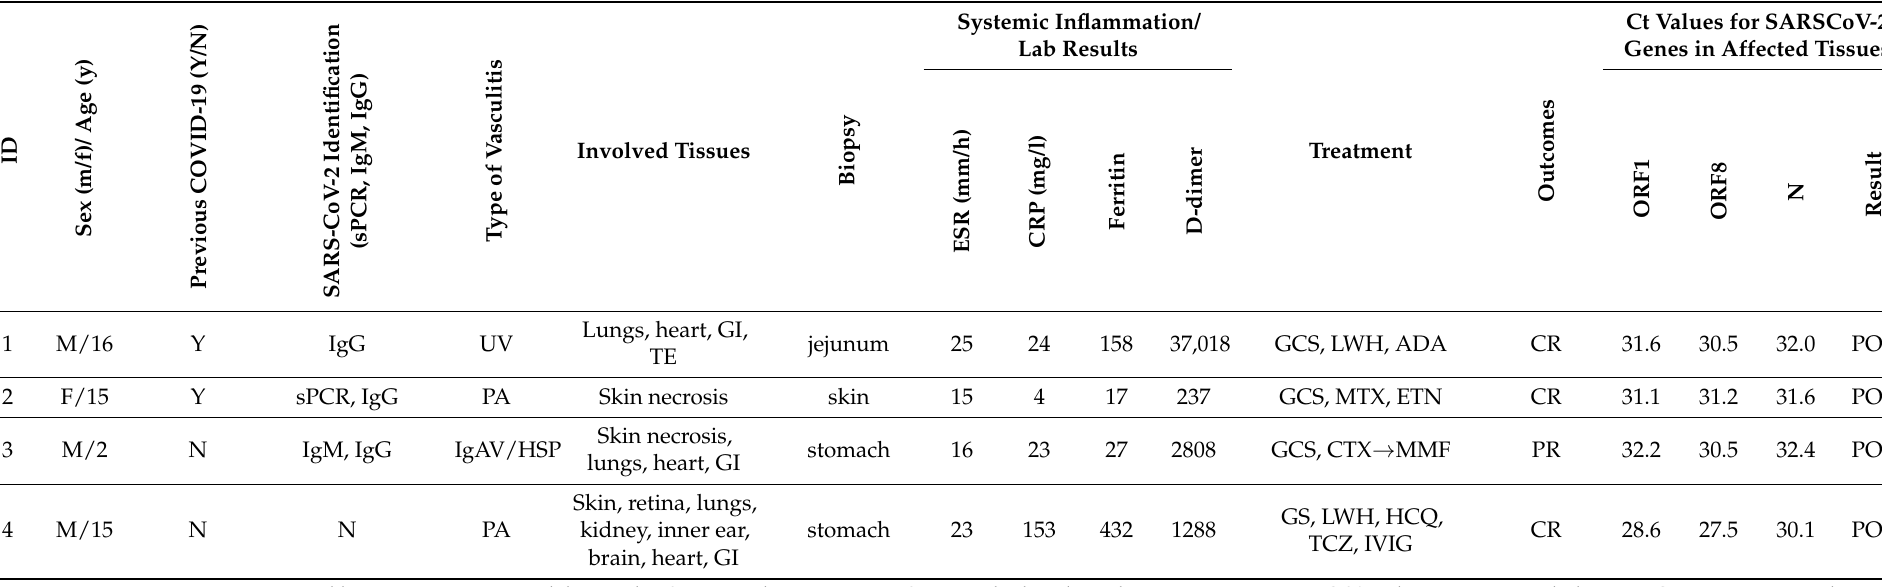
Table 1. Clinical and laboratory characteristics of four patients with vasculitis associated with SARS-CoV-2, types of therapy, and